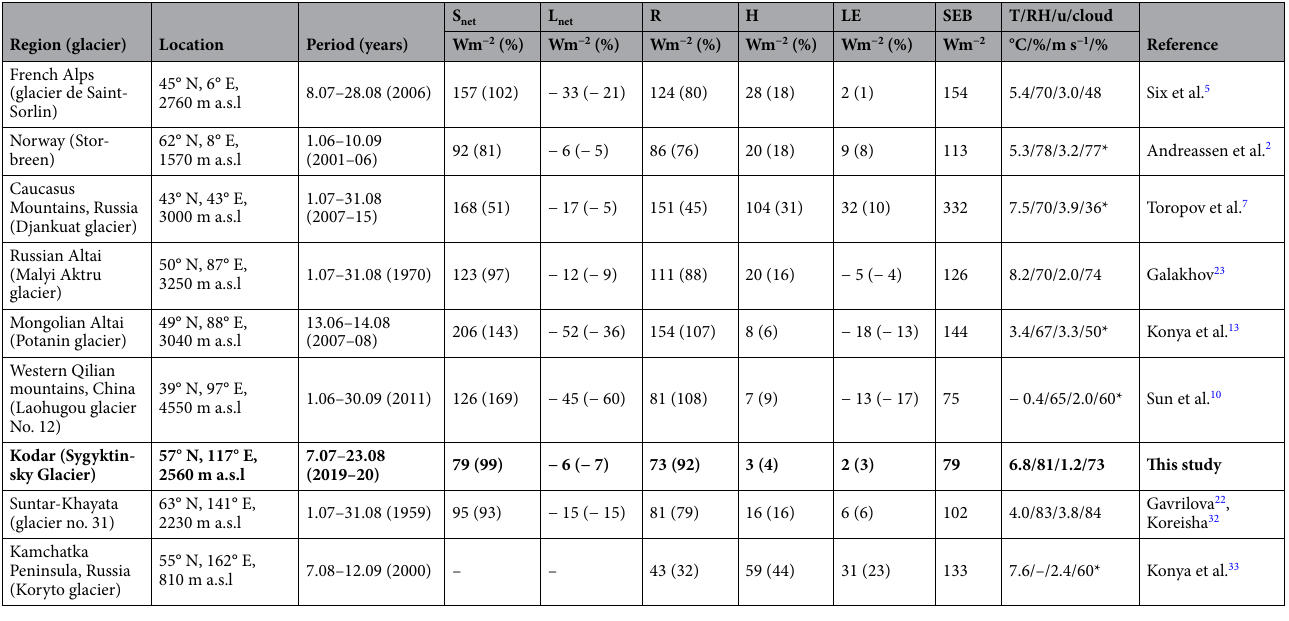
Table 3. Comparison of the components of surface energy balance and meteorological parameters on several mid-latitude glaciers of Eurasia. An asterisk (*) indicates the monthly data on total cloudiness from the ERA- Interim reanalysis of the European Centre for Medium-Range Weather Forecasts (https:// www. ecmwf. int/). A dash (–) indicates no